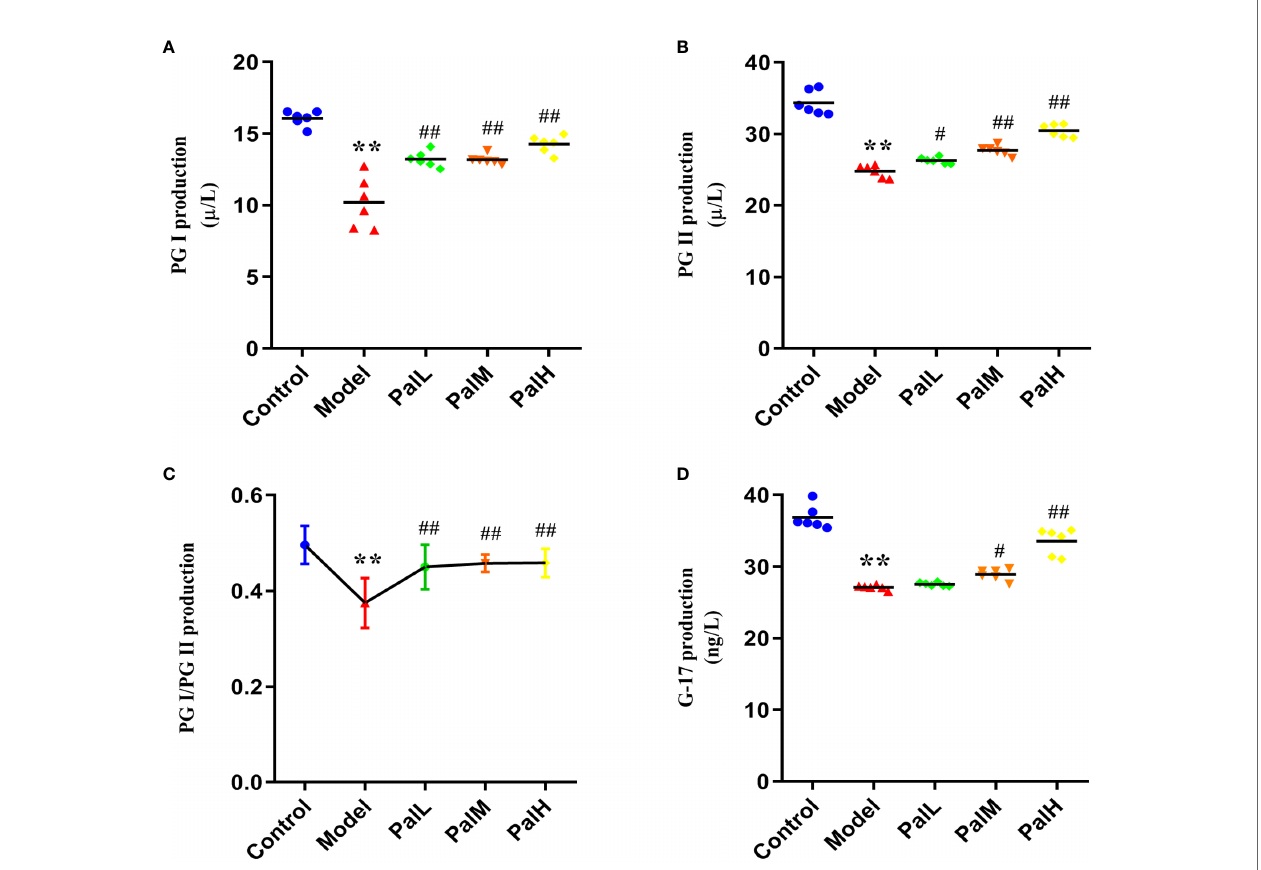
FIGURE 3 | Pal improves biomarkers in serum of H. pylori – induced chronic atrophic gastritis (CAG). (A – D) PG I (A) , PG II (B) , PG I/PG II (C) , and G-17 (D) production in serum was measured by ELISA (n=6). ** P < 0.01 vs control group. # P < 0.05 and ## P < 0.01 vs model group. PalL (10 mg/kg); PalM: (20 mg/kg); PalH: (40